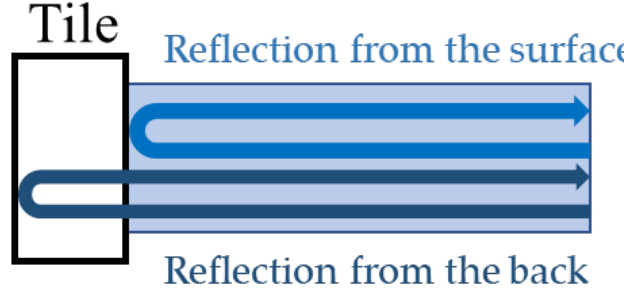
Figure 7. Behavior of FS-THz waves in tile thickness measurements.